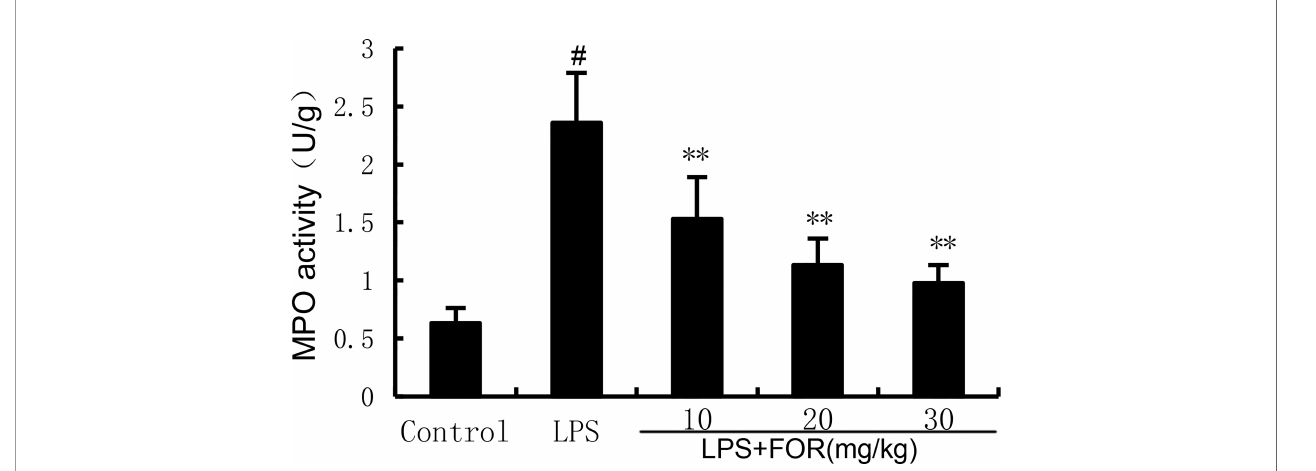
FIGURE 2 | FOR suppresses LPS-induced MPO activity. The results are expressed as the mean ± SEM of triple parallel measurements. # ( P < 0.01) is signi fi cantly different from control group; **( P < 0.01) is signi fi cantly different from LPS